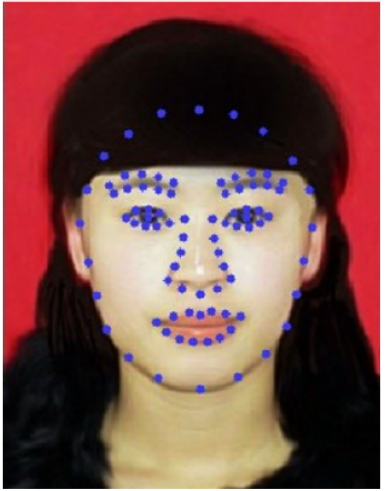
Figure 4. The 81 facial points detected in a face